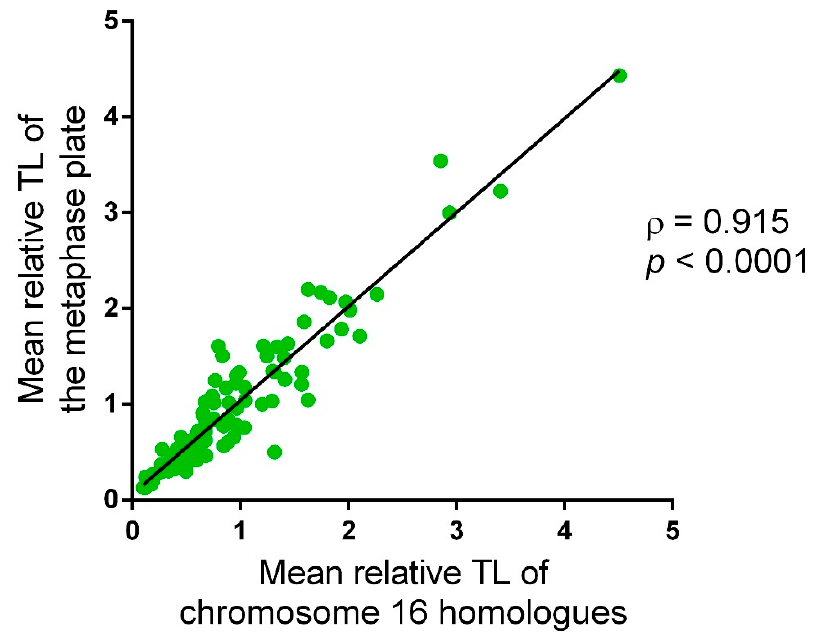
Figure 2. The correlation between the mean relative telomere length (TL) of chromosome 16 homo- logues and that of other chromosomes in the same metaphase assessed in 107 metaphases across 10 chorionic cytotrophoblast samples (Spearman test, ρ = 0.915; p < 0.0001).